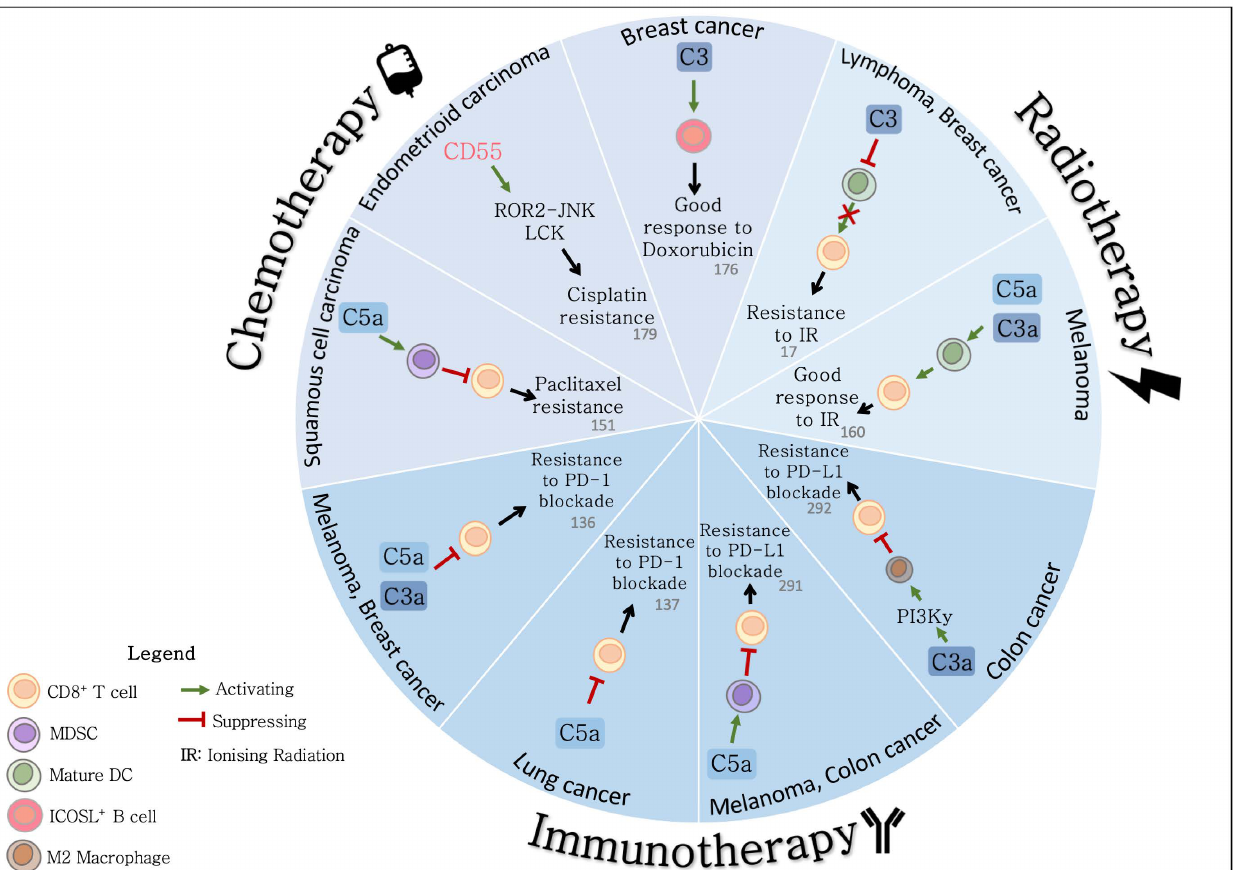
Figure 2. The influence of complement on response to treatment within the tumour microenvironment. The current understanding of the roles for complement in the response to radiotherapy, chemotherapy and monoclonal antibody-based immunotherapies are depicted. Green arrows illustrate events where complement component(s) have been demonstrated to activate an immune cell or signalling pathway, while inhibitory effects are shown in red. Black arrows indicate the observed influence of complement activities on the therapeutic efficacies of the designated chemotherapy, radiotherapy or immunotherapy treatment, in specified cancer